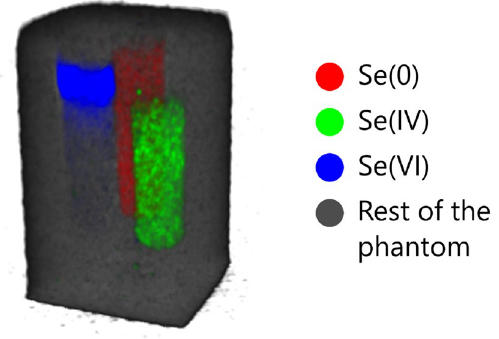
Figure 8. 3D visualisation of different chemical species of Se inside the phantom. The rendering was made with 3D Slicer 4 22